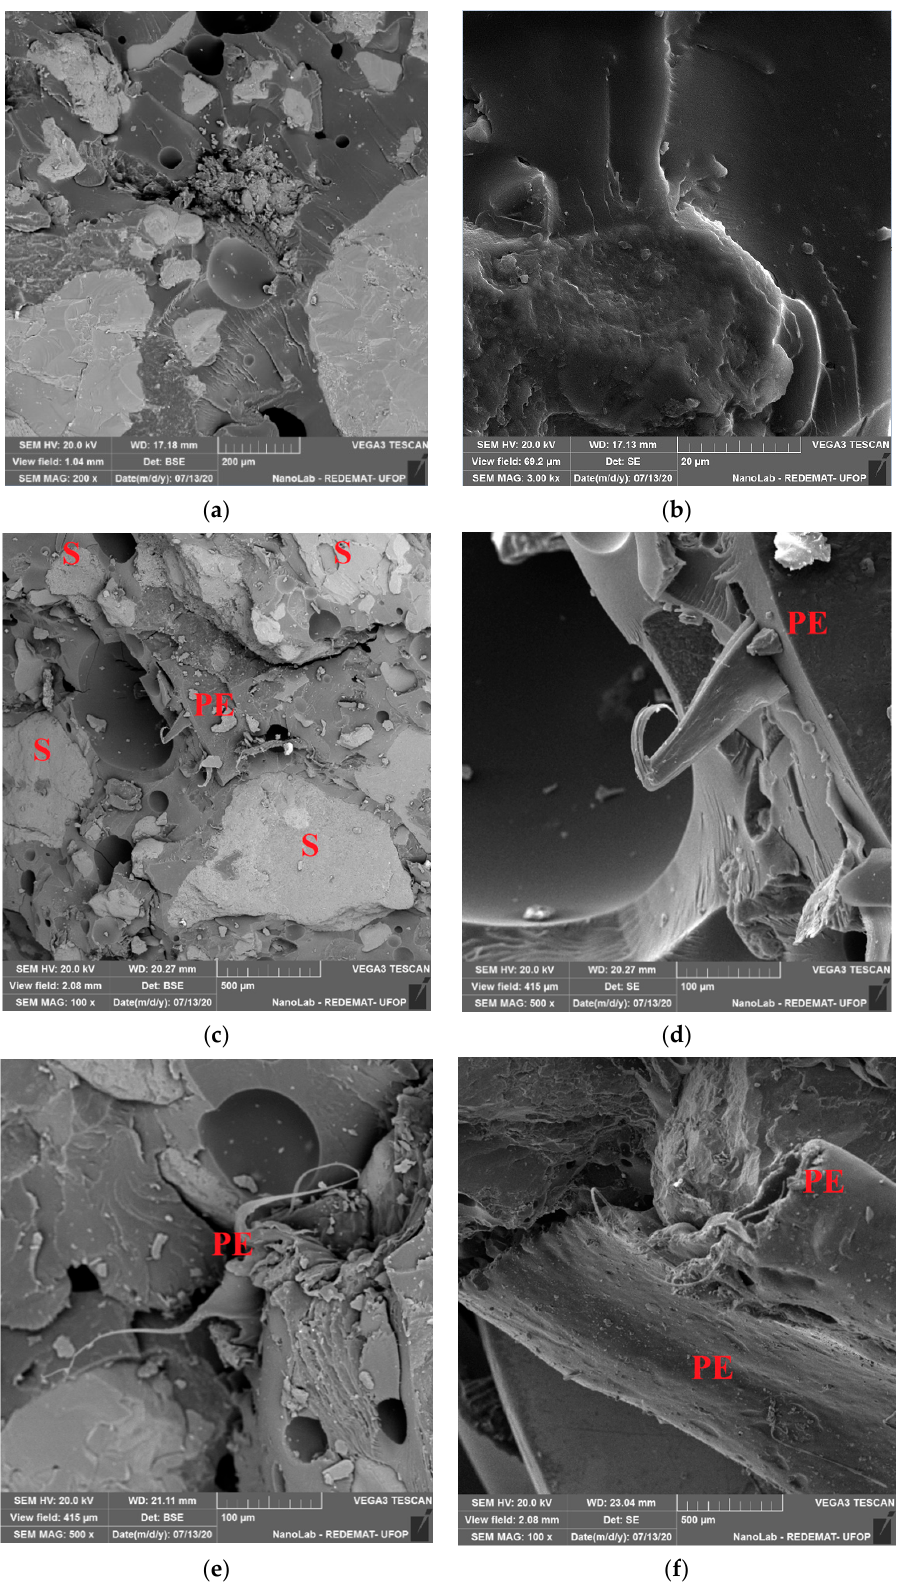
Figure 8. Backscattered electron (BSE) and Secondary electron (SE) images of mortar samples marked in the experiment plan as: 1 (BSE—( a ), SE—( b )), 10 (BSE—( c , e ) ; SE—( d , f )), PE—polyethylene waste, S—quartz sand.